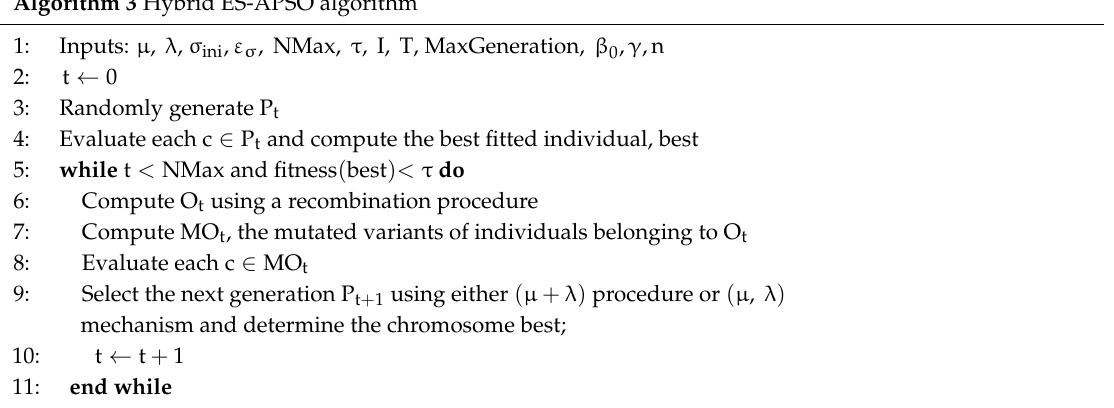
Algorithm 3 Hybrid ES-APSO